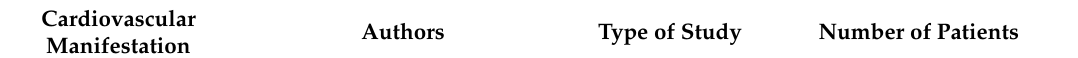
Table 1. Table summarizing the various cardiovascular manifestations of